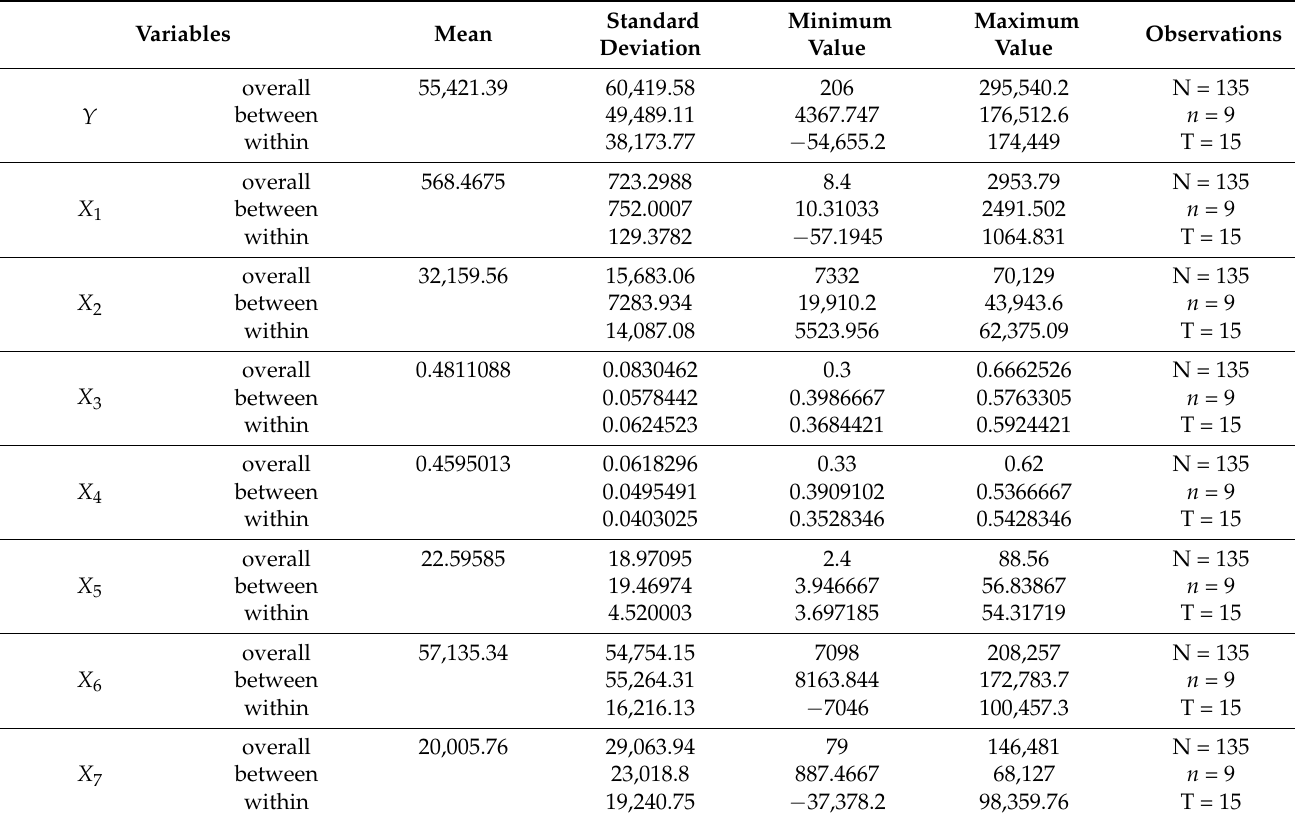
Table 2. Descriptive statistics (period = 2005–2019, number of provinces = 9).